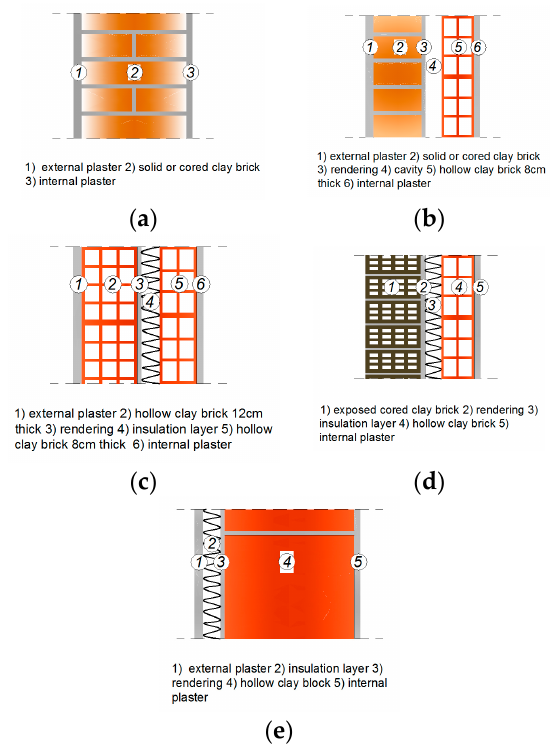
Figure 3. Typical infill types used in Italian Reinforced Concrete (RC) buildings: ( a ) single layer of solid clay brick; ( b ) cavity wall with solid and hollow clay bricks; ( c ) cavity wall with two layer of hollow clay bricks; ( d ) cavity wall with exposed cored and hollow clay bricks; and, ( e ) single layer of hollow clay brick with high insulation performance.